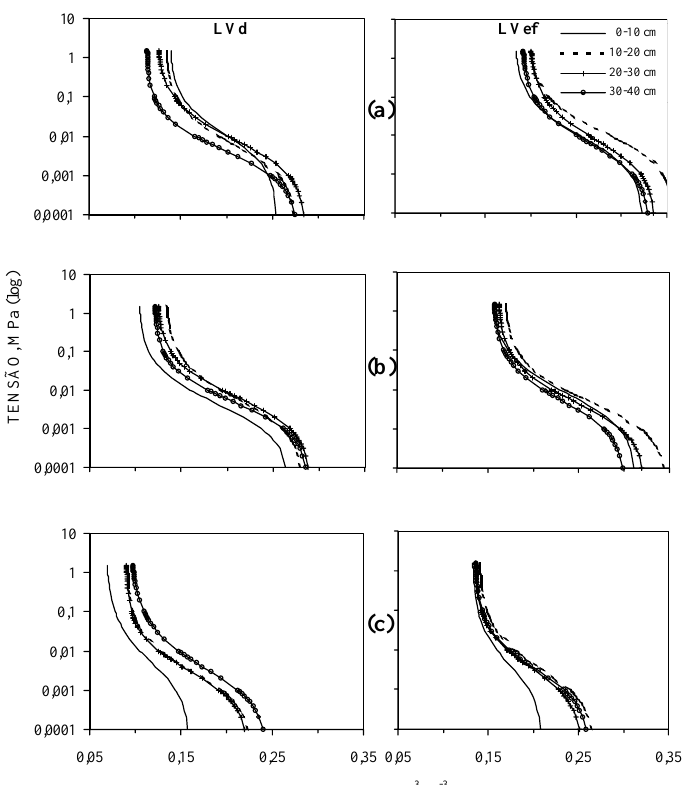
Figura 1. Curvas de retenção de água do Latossolo Vermelho distrófico caulinítico e Latossolo Vermelho eutroférrico oxídico, em quatro profundidades ((a) algodão; (b) cana-de-açúcar; (c) mata